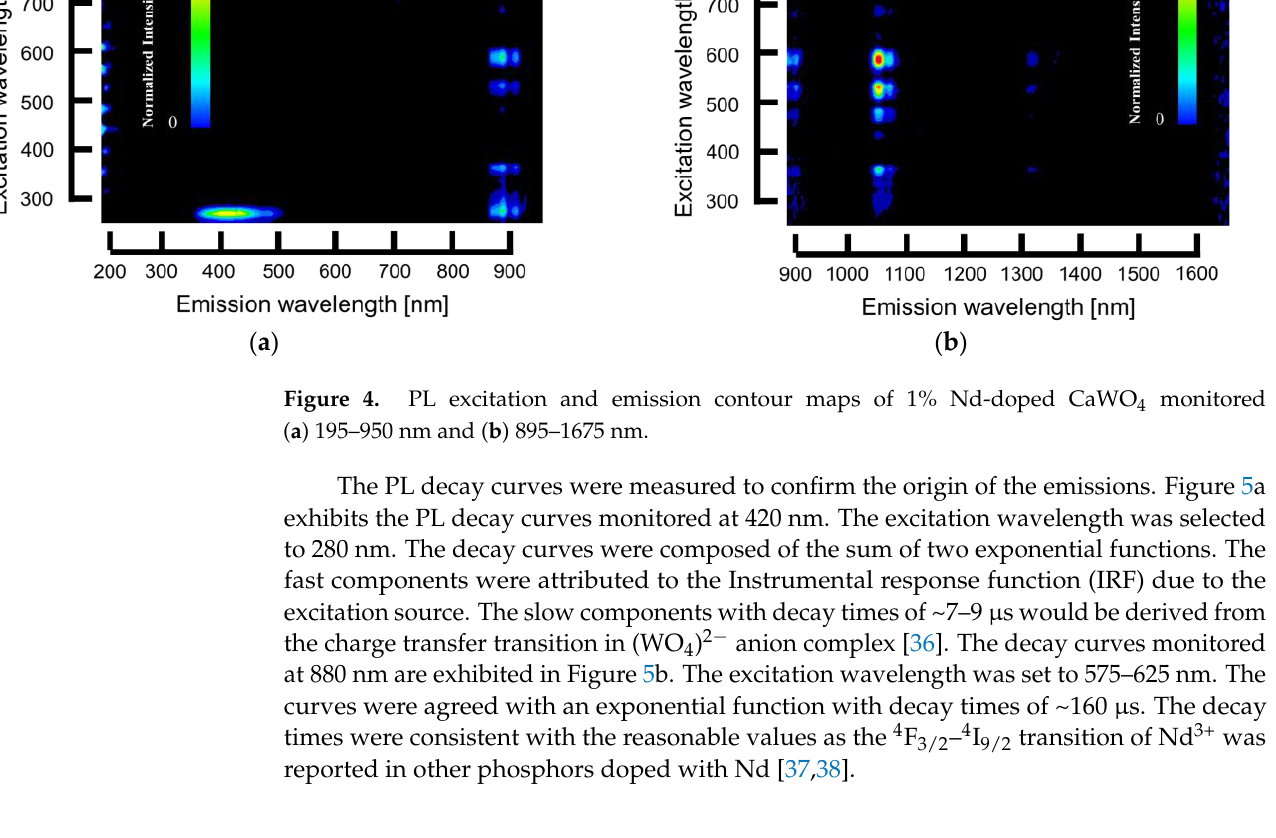
Figure 4. PL excitation and emission contour maps of 1% Nd-doped CaWO 4 monitored ( a ) 195 – 950 nm and ( b ) 895 – 1675 nm.